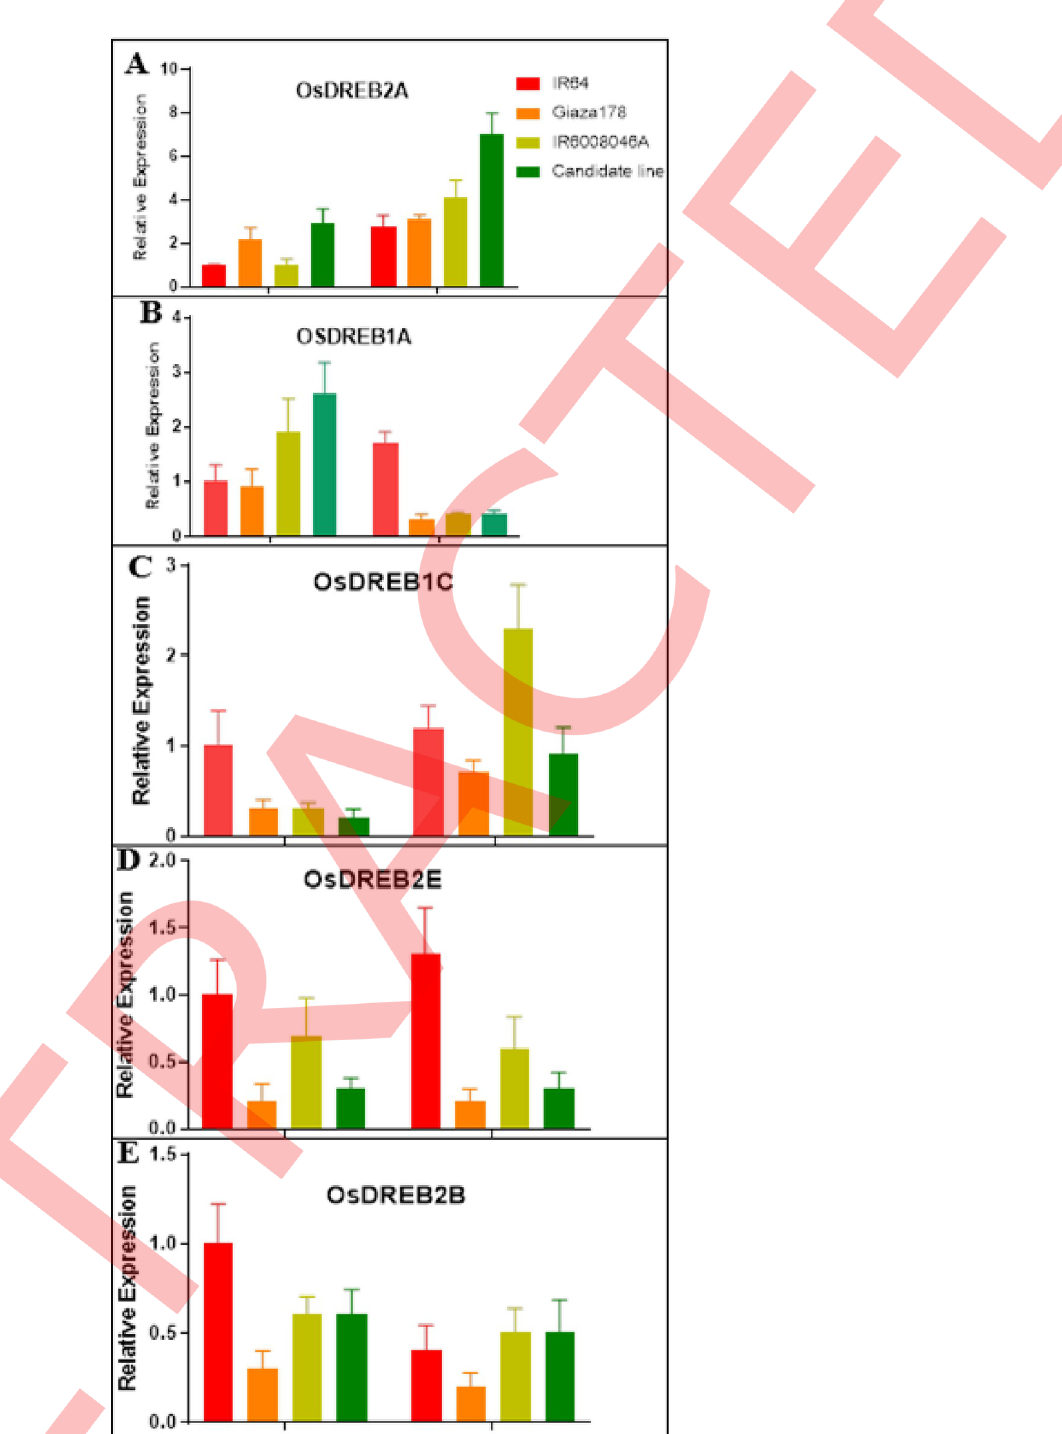
Fig 8. The expression level of OsDREB2A (A), OsDREB1A (B), OsDREB1C (C), OsDREB2E (D) and OsDREB2B (E); under normal and drought stress conditions. Data are represent as means ± SEM, (n = 6).